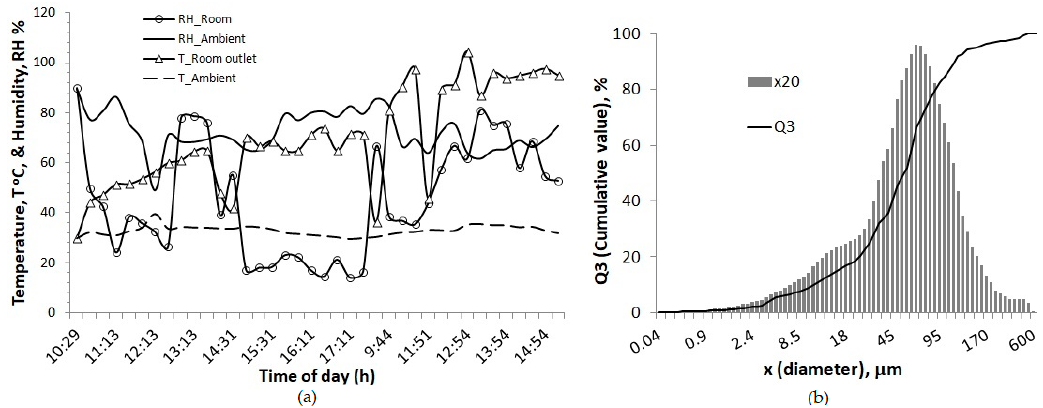
Figure 5. ( a ) Temperature and humidity of the smoking chamber and the ambient air, ( b ) particle size distribution.